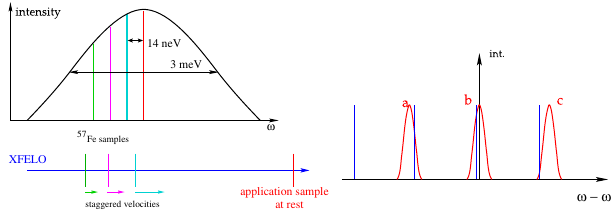
FIG. 4. Using the Doppler shift on multiple samples (left) to increase the signal strength and (right) to obtain a sign signal for the feedback in addition to the maximum